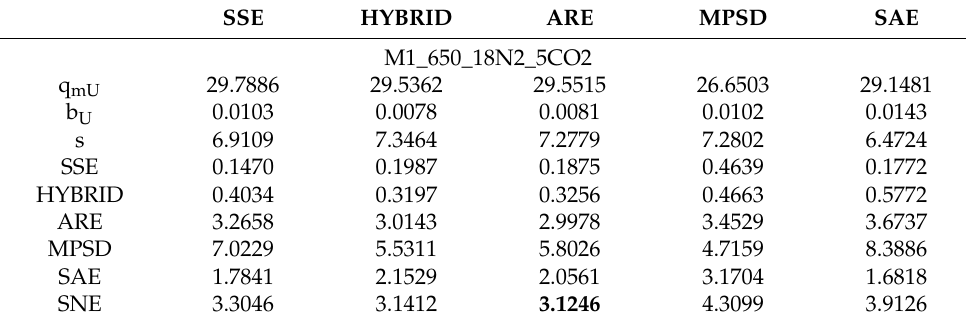
Table 7. Unilan isotherms constants with error analysis